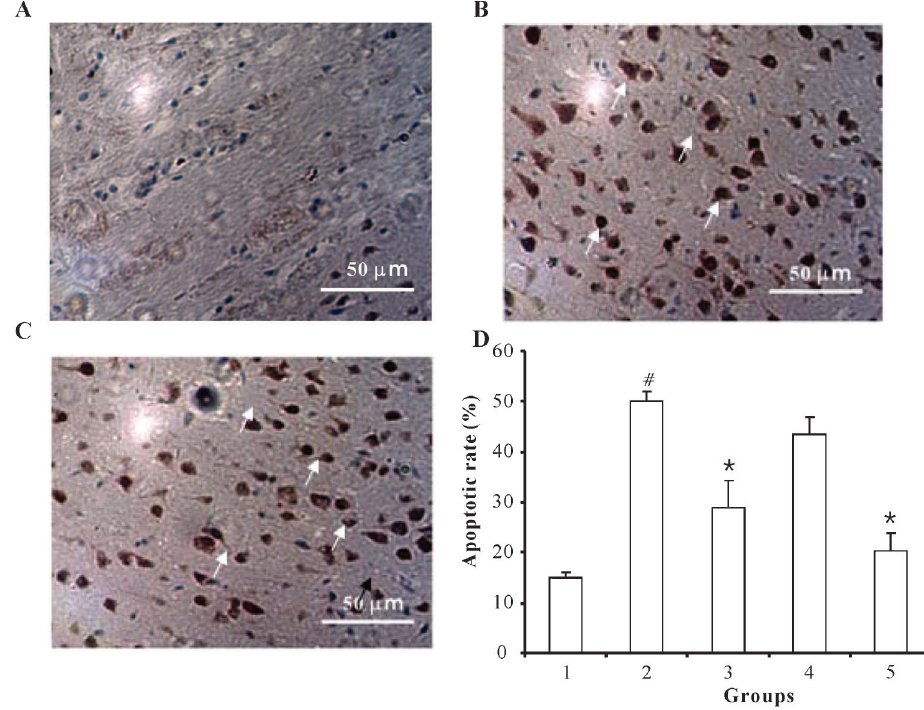
Figure 4. Ischemic preconditioning (IPC) inhibits ischemic reperfusion (I/R)-induced apoptosis 24 h post-ischemic injury (TUNEL staining). A , Representative image of sham control. B , Representative image of I/R. C , Representative image of 5 6 5 6 5 min IPC++I/R group. D , Pooled data are reported as means±SE of 4 rats in each group. Groups: 1) sham control, 2) I/R, 3) 5 6 5 6 5 min IPC++I/R, 4) 3-methyladenine++5 6 5 6 5 min IPC++I/R, and 5) rapamycin++5 6 5 6 5 min IPC++I/R. The arrows indicate the apoptotic cells. # P , 0.05, compared to sham control group; *P , 0.05, compared to I/R group (one-way ANOVA followed by the Bonferroni